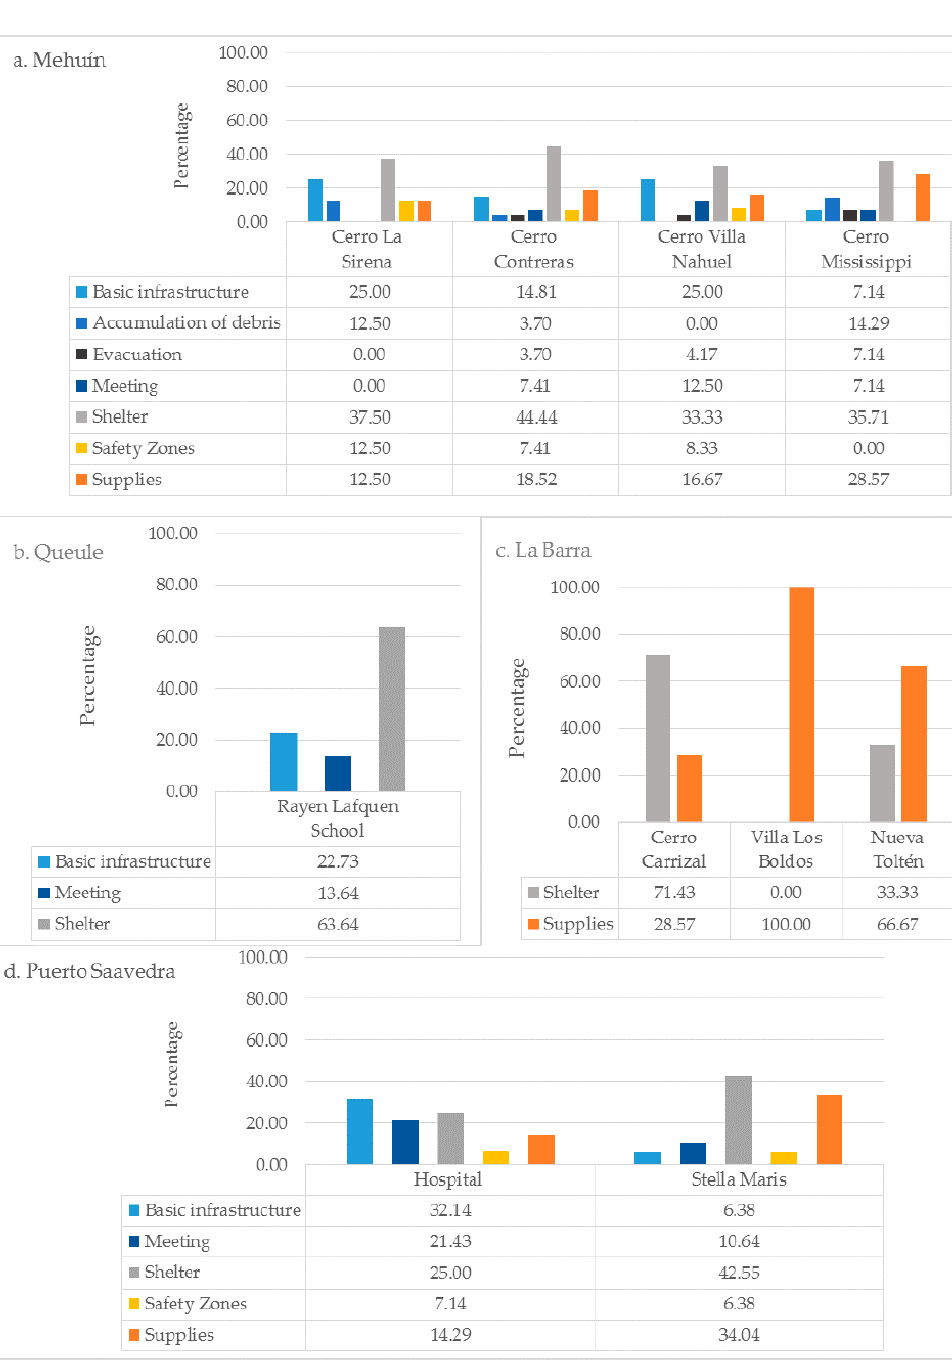
Figure 9. Sites with high diversity in governance.